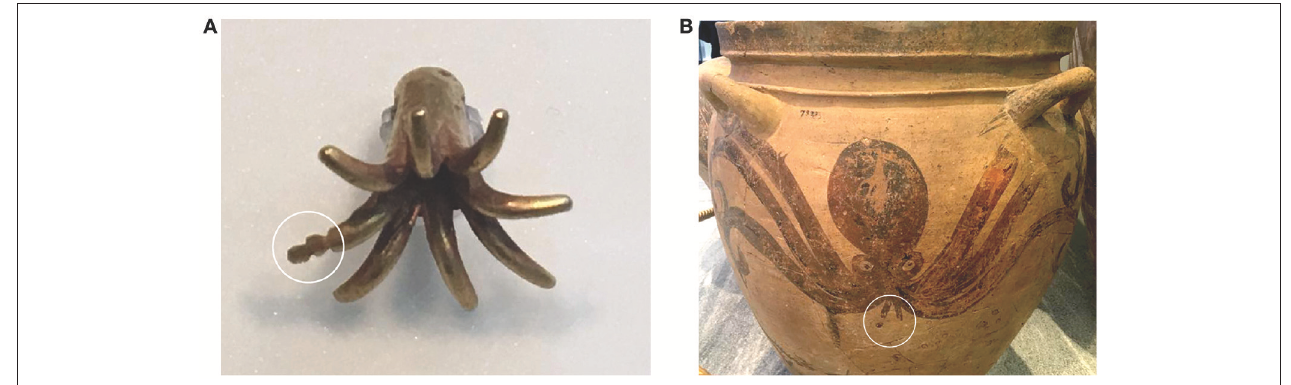
FIGURE 4 | A gold octopus pendant is showing a hectocotylus (A) , and a large octopus ceramic pot is describing two regenerated arms (B) . Collections of Heraklion Archaeological Museum, Crete Greece (photographs by R. Nakajima).